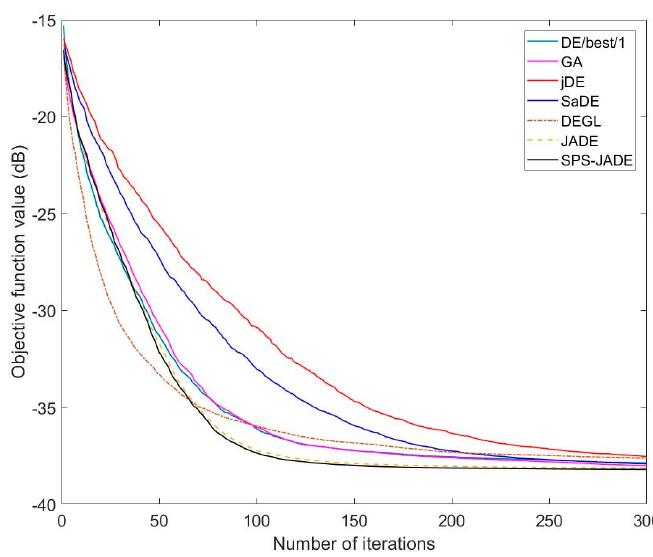
Figure 4. Average convergence rates with sidelobe suppression.